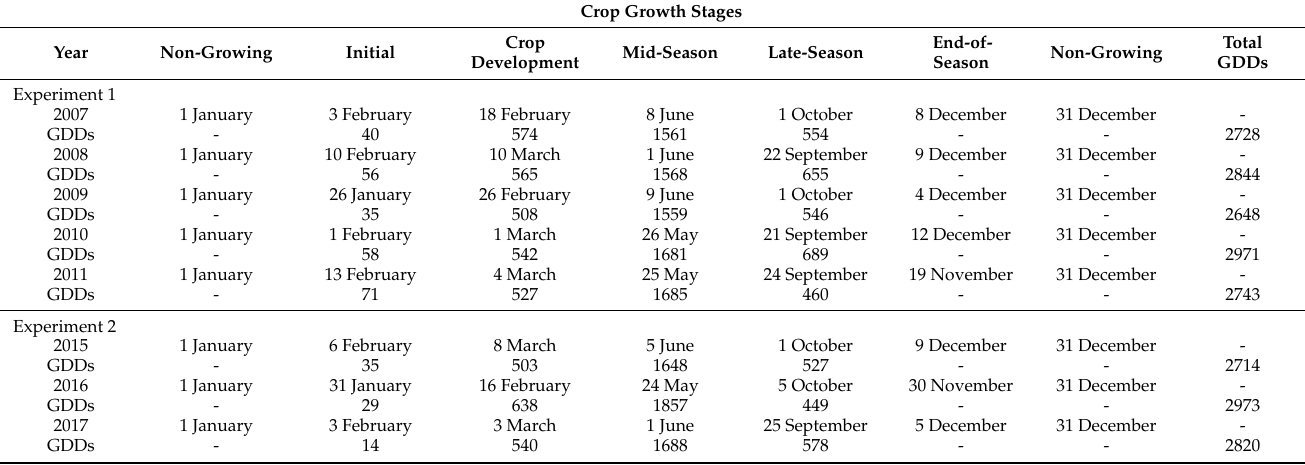
Table 3. Dates of the crop growth stages and growing-degree days (GDDs) during the experimental